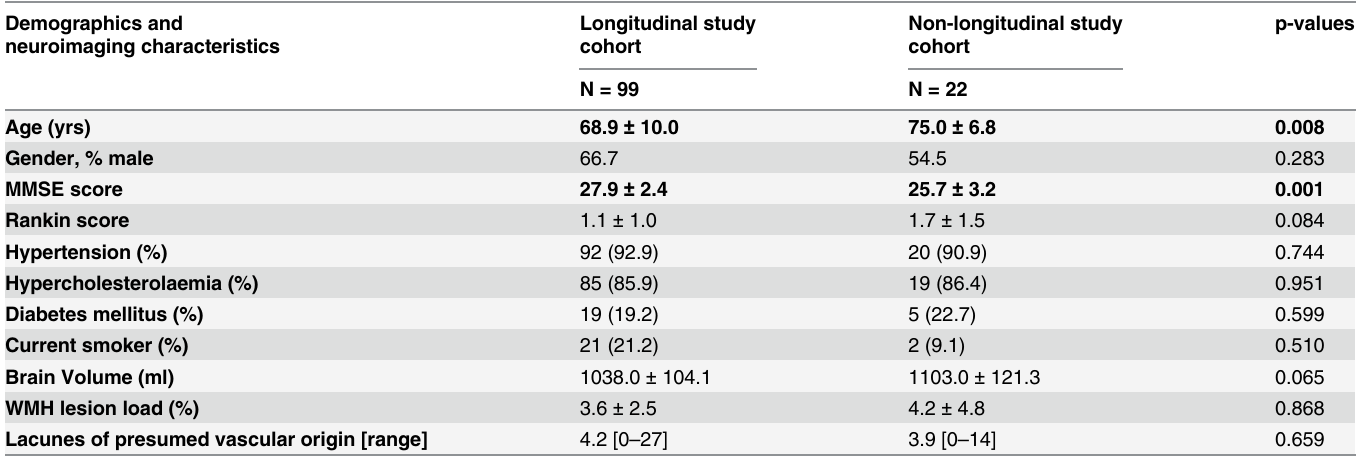
Table 1. Baseline characteristics of the longitudinal study